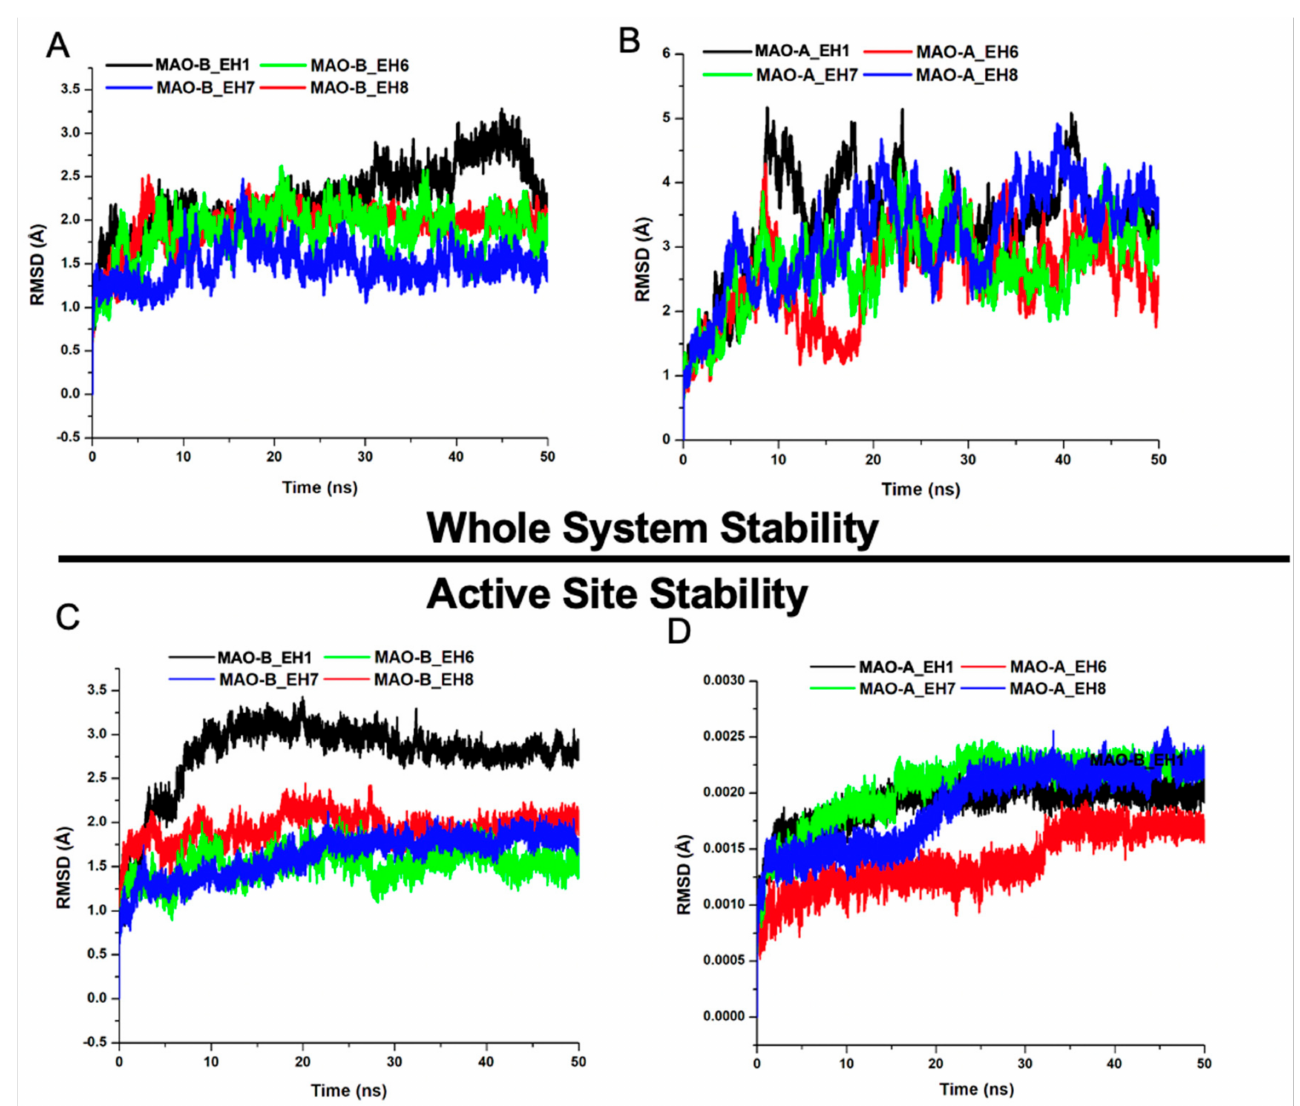
Figure 5. Comparative root mean square deviations (RMSDs) of the C α carbon atoms of the compounds in whole systems for MAO-B ( A ) and MAO-A ( B ) and in active sites for MAO-B ( C ) and for MAO-A ( D ). ( A , C ) EH1 , black; EH6 , green; EH7 , blue; and EH8 red. ( B , D ) EH1 , black; EH6 , red; EH7 , green; and EH8 ,